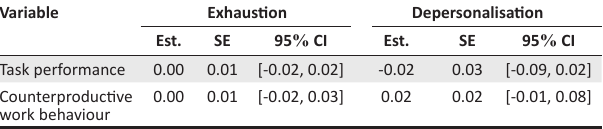
TABLE 6: Indirect effect of emotional demands on task performance and counterproductive work behaviour.